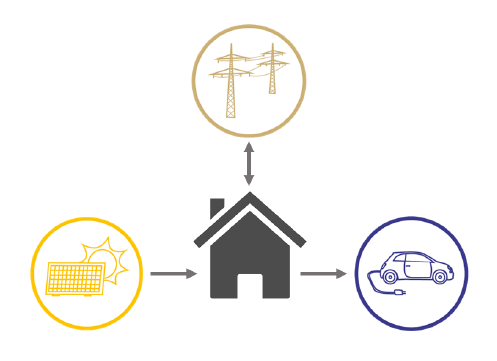
Figure 1. Configuration of the households under consideration of their load